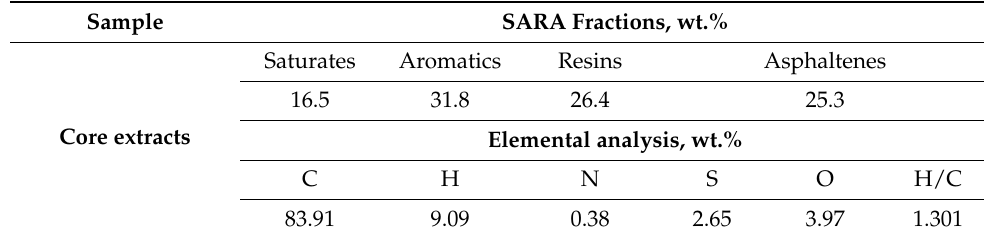
Table 6. Group composition and elemental analysis of oil saturated crushed